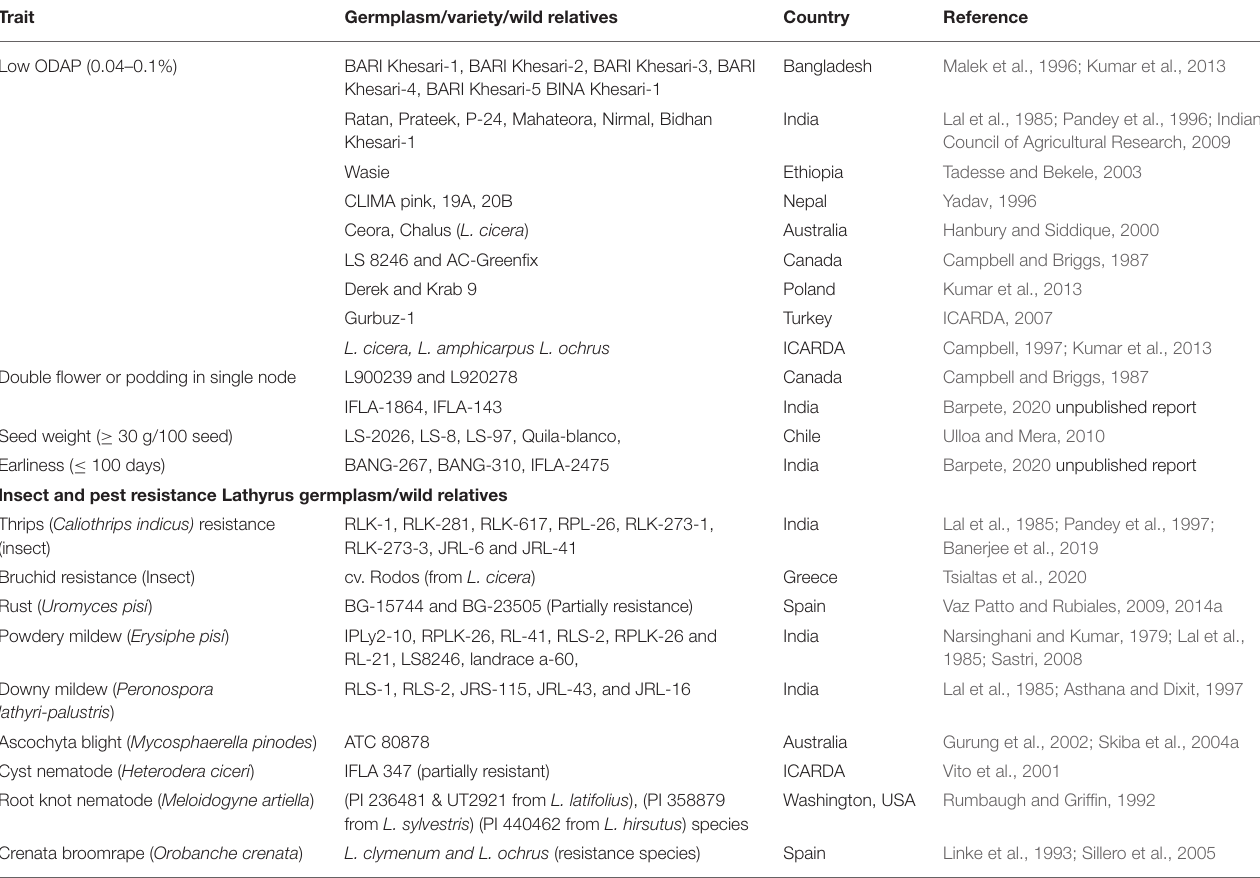
TABLE 2 | Potential source for grass pea improvement.